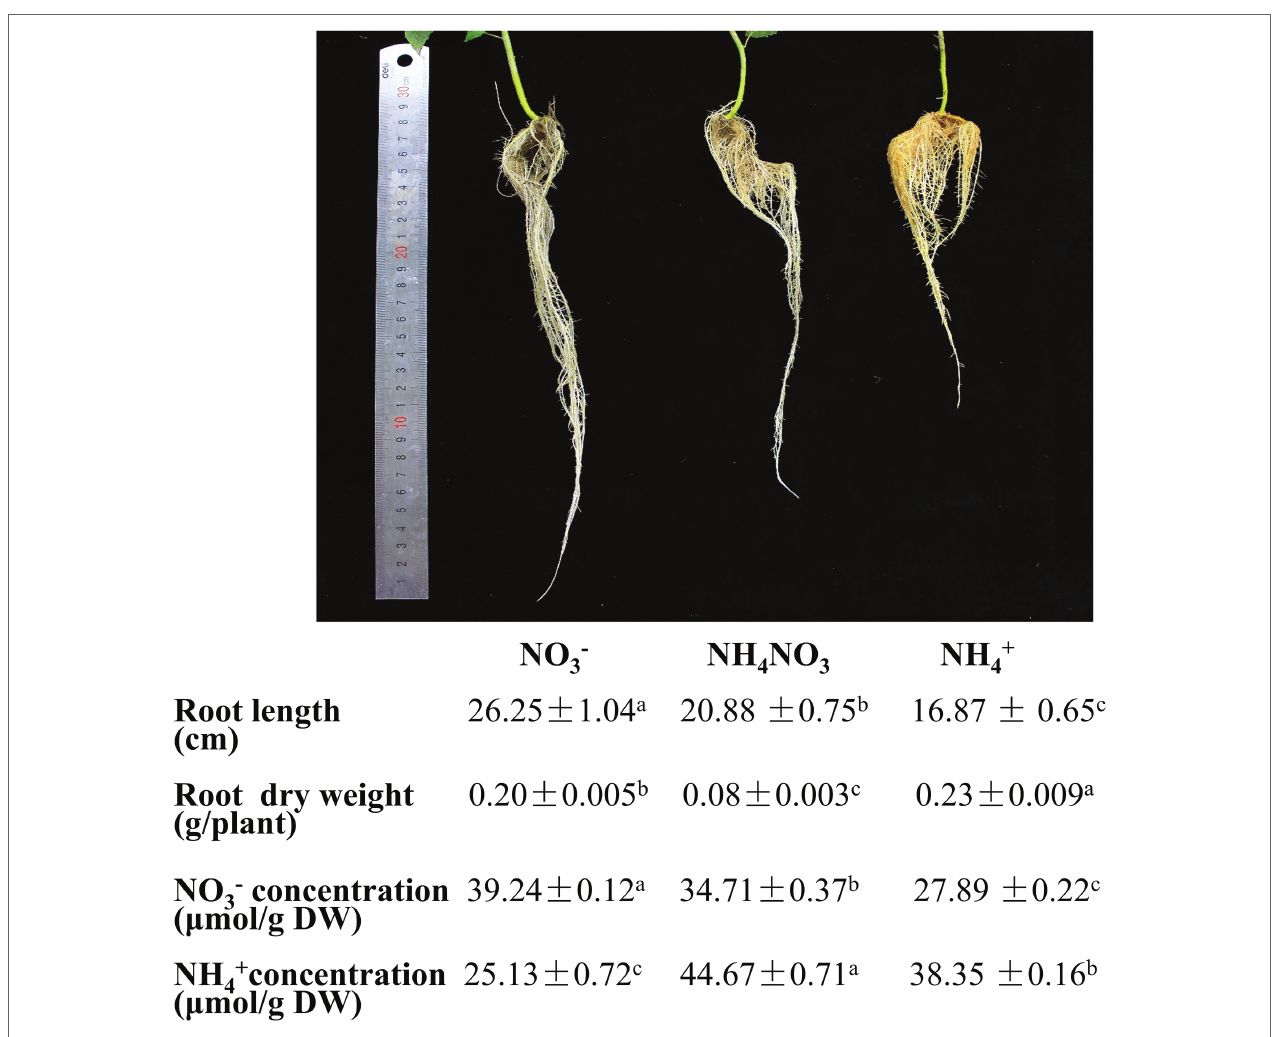
FIGURE 1 | Morphological parameters and physiological indexes of P. x canescens roots under different nitrogen fertilization treatments for 21 days. Phenotypes of P. x canescens cultured under 1 mM NO 3- , 500 μM NH 4 NO 3 and 1 mM NH 4+ for 21 days. Statistical analysis of root length, dry weight, NO 3- concentration and NH 4+ concentration of roots. The data indicate the mean ± SE (n = 12). a, b, and c indicate significant differences based on ANOVA and Duncan's test (P <